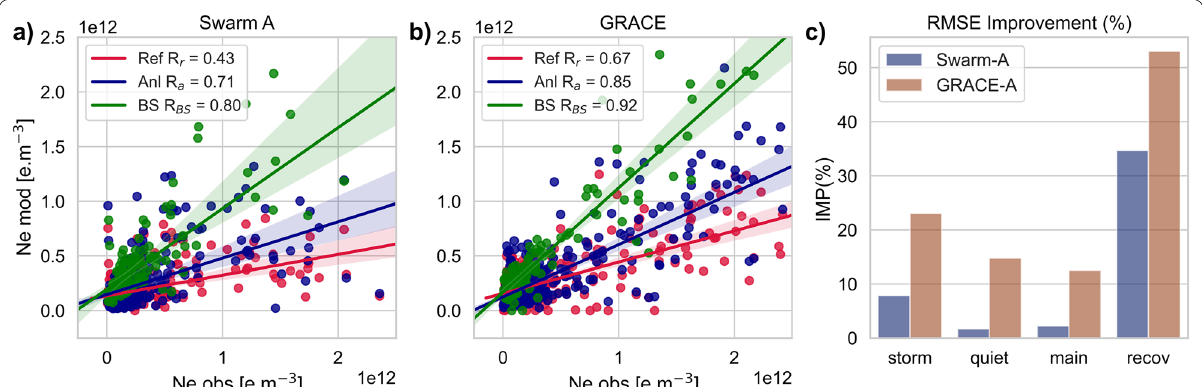
Fig. 5 Electron density reference (red), analysis (blue) and B‑Spline model (green) regression against observations along the orbit a Swarm‑A and b GRACE. The regression fit (straight line) is represented with its confidence interval (shadowed area). The correlation improves from reference to analysis in both cases and the B‑Spline model exhibits a very strong correlation with the measurements. The RMSE improvement between reference and analysis separated by satellite and storm phases ( c ), shows the data assimilation upgrade increasing with the storm periods, with an average value of approximately 8% for Swarm‑A and 22% for GRACE